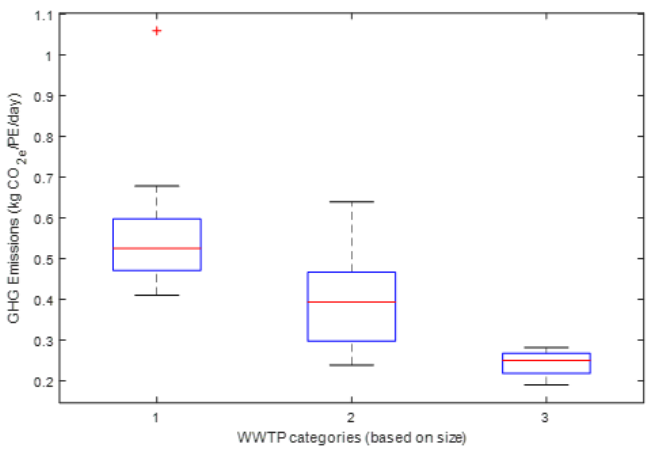
Figure 7. GHG emissions by size of WWTP.